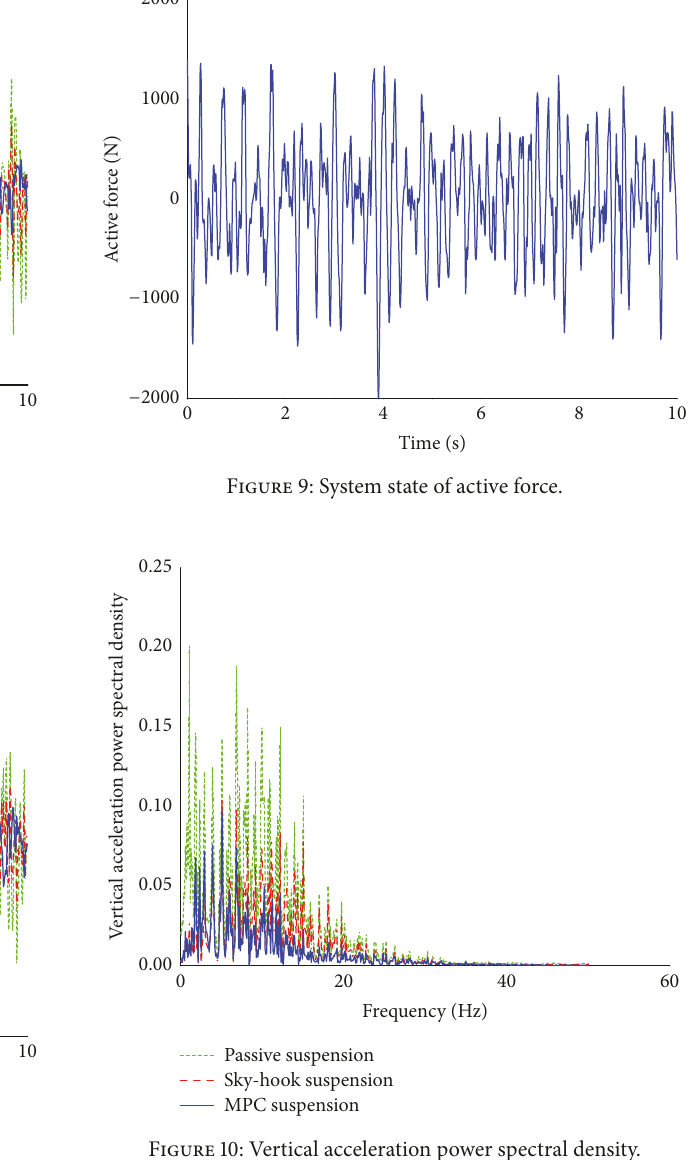
Figure 10: Vertical acceleration power spectral